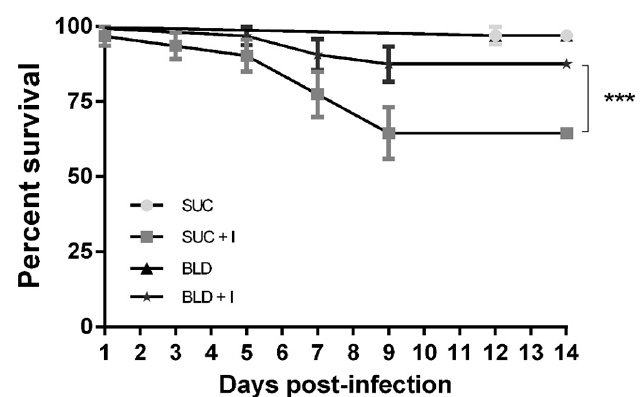
Figure 1. Susceptibility of Aedes aegypti adult female mosquitoes to fungal infection. SUC, sucrose-fed mosquitoes treated with Tween 80 (control); SUC + I, sucrose-fed mosquitoes infected with M. anisopliae ; BLD, blood-fed mosquitoes treated with Tween 80 (control); BLD + I, blood-fed mosquitoes infected with M. anisopliae. Survival rates of A. aegypti ( n = 45 per treatment) exposed to conidia of M. anisopliae ESALQ (ESALQ818) at a final dose of 10 6 spores mL − 1 . The graph represents three independent experiments and data were analyzed with Kaplan–Meier survival analysis (GraphPad Prism 6 software). Error bars indicate the SEM. The fungus significantly increased SUC + I mortality compared to all other treatments (*** p < 0.001).